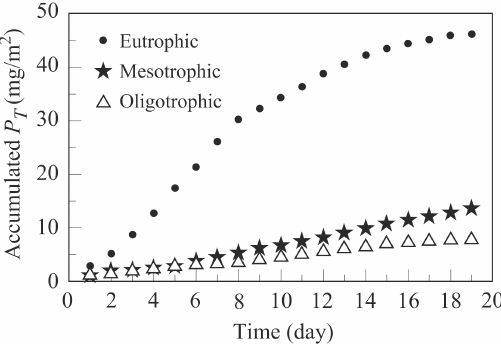
Figure 5. Cumulative areal algal (as mg of Chl a /m 2 ) over time.